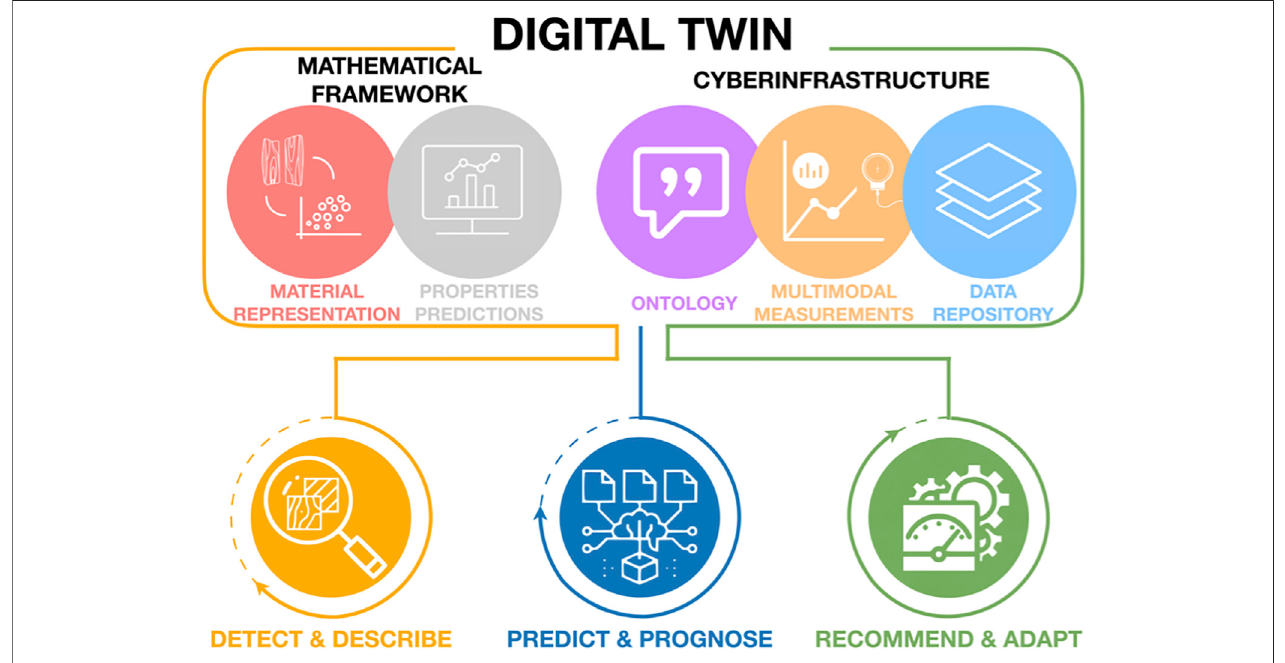
FIGURE 3 | The main components of the proposed roadmap for building digital twins for material systems.